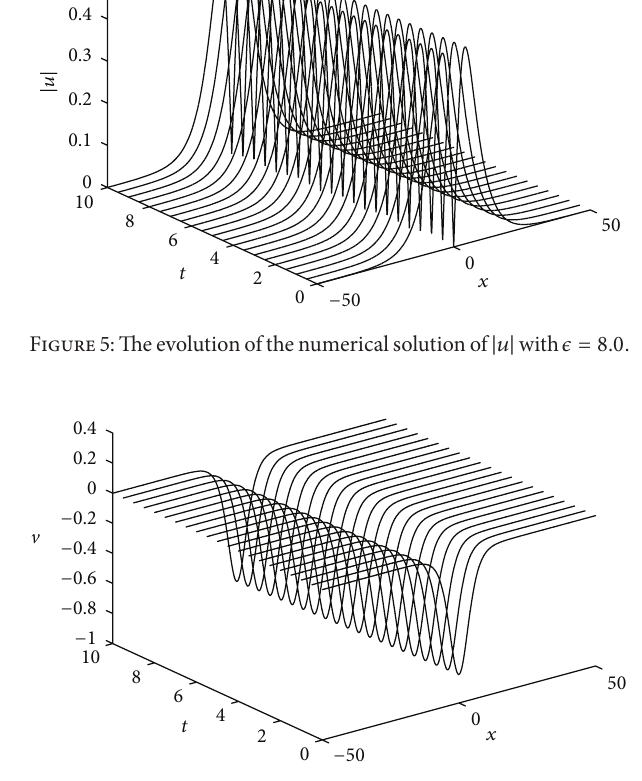
Figure 6: The evolution of the numerical solution of V with 𝜖 = 8.0 .